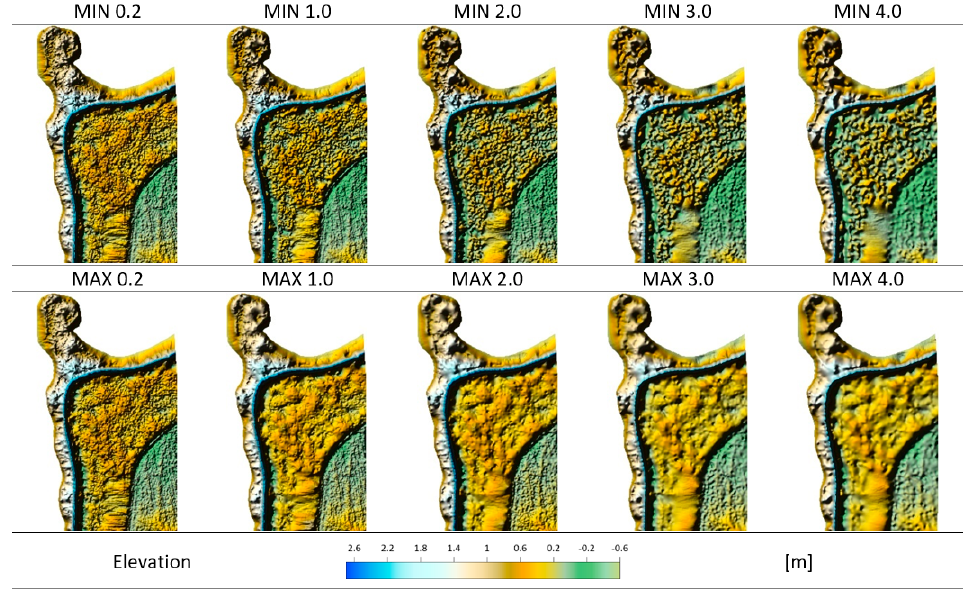
Figure 19. Comparison of DTMs under the RBF method.